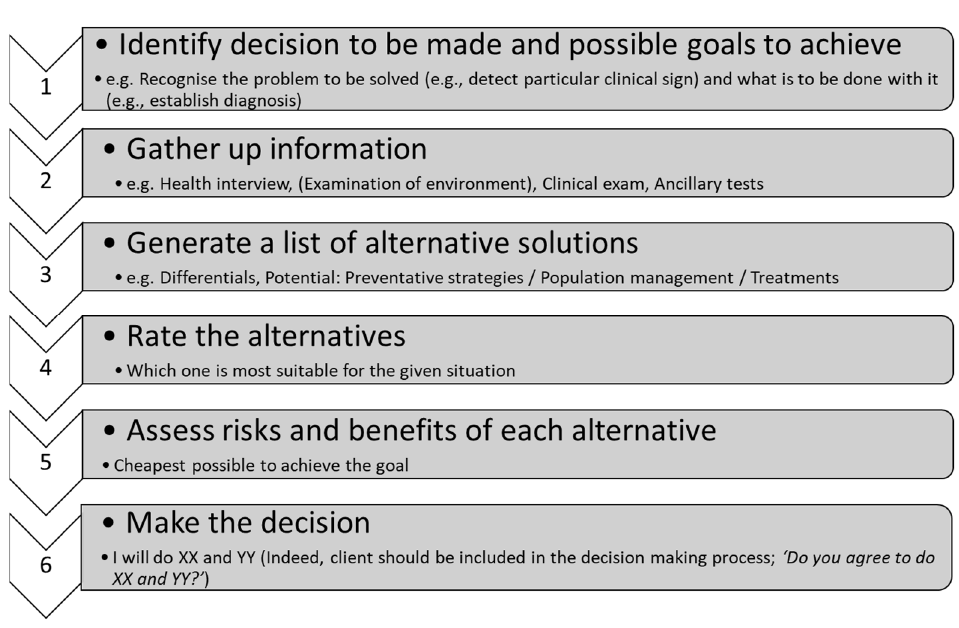
Figure 2. Decision-making process applicable to veterinary medical problem.